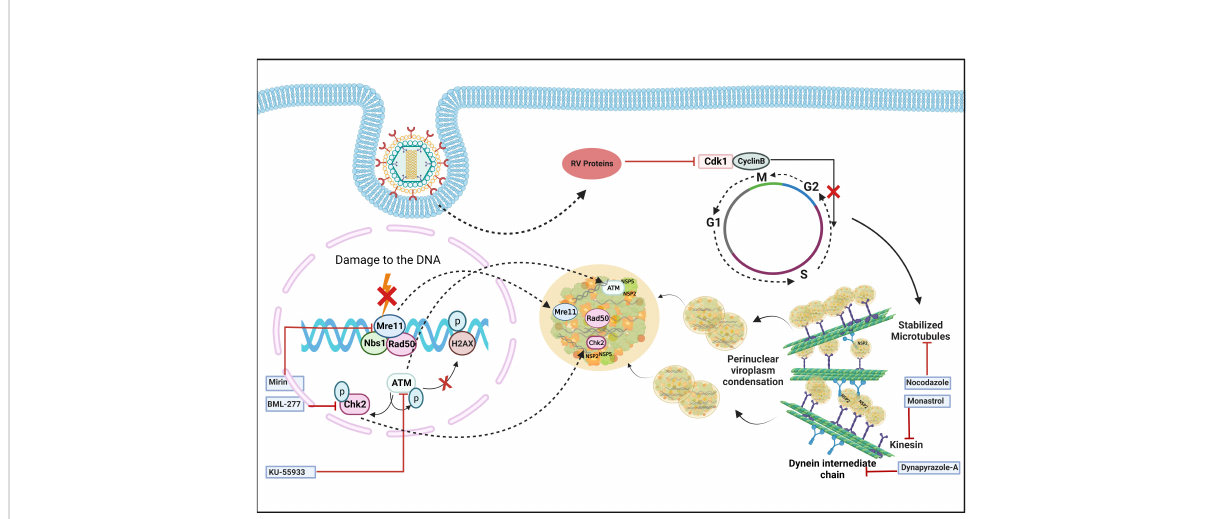
FIGURE 3 Host cellular contribution in regulating viroplasm condensation and maturation. RV blocks mitotic entry of the host cell cycle by prolonging intra S-phase retention. This is enabled by the depletion of cyclin B1 and subsequent inhibition of the Cdk1-cyclin B1 complex by multiple RV proteins. Inhibition of mitotic entry ensures the preservation of hyperacetylated and stabilized microtubular structures which along with the kinesin motor protein Eg5 and dynein facilitate viroplasmic condensation and peri-nuclear relocalization. Targeting microtubule, Eg5 kinesin, and dynein intermediate chain by small molecules nocodazole, monastrol, and dynapyrazole-A respectively, impairs viroplasm dynamics. RV also activates MRN-ATM-Chk2 branch of DDR during infection in absence of nuclear DNA damage and l -H2AX positive nuclear foci. Moreover, MRN components, ATM and Chk2 relocate to the cytoplasm and co-localize with viroplasms. Targeting Mre11, ATM, and Chk2 by small molecule inhibitors Mirin, KU55933, and BML-277, respectively, antagonize RV replication. KU55933 and BML-277 prevent viroplasm condensation and